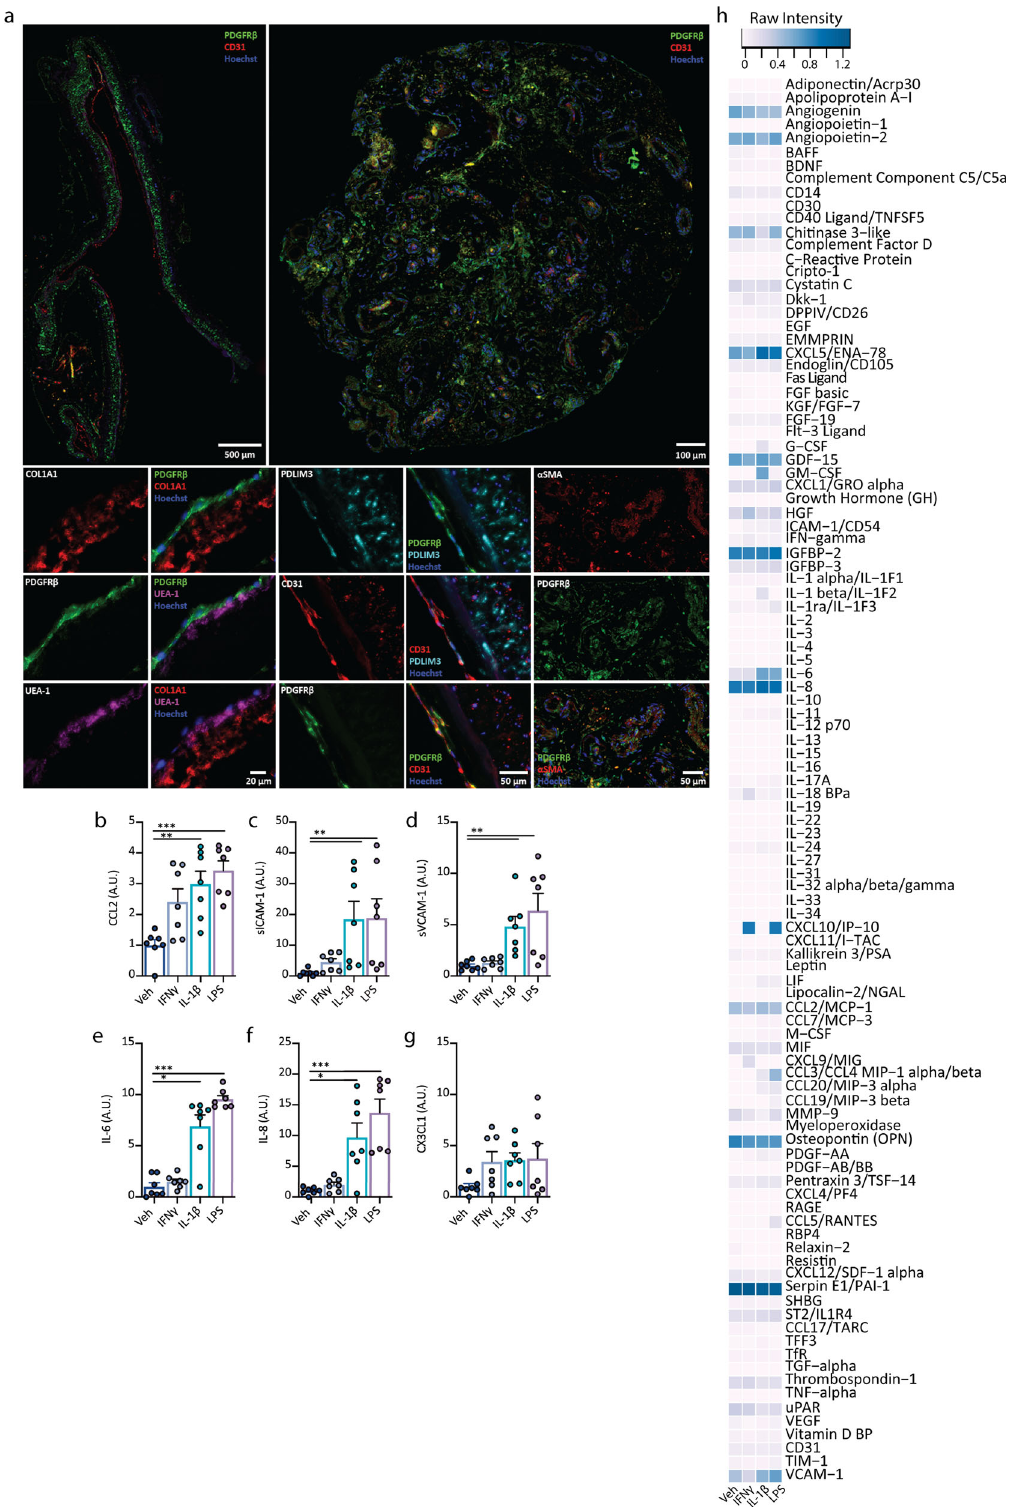
Fig. 5 Characterisation of leptomeningeal explant cell types and in fl ammatory signature. a Immunohistochemical staining of LME for vascular cells types including pericytes (PDGFR β ) endothelial cells (CD31), fi broblasts (PDLIM3), smooth muscle cells ( α SMA) and extracellular matrix protein deposition (COL1A1). b – g Secretions from meningeal explants following in fl ammatory stimulation with vehicle (white bars), IFN γ (blue bars), IL-1 β (cyan bars) or LPS (violet bars) were investigated using cytometric bead arrays ( n = 2 cases used: HC171, AZ129, 3 – 4 explants per case), values normalised to vehicle condition. One way ANOVA, Dunnett ’ s multiple comparisons test, mean ± SEM. *** p < 0.001, ** p < 0.01, * p < 0.05, raw values Figs. S7 and 8. h Proteome pro fi lers were used to detect secretions from human brain meningeal explants (pooled from fi ve explants per condition, one case: H250) after 24 h of in fl ammatory stimulation with vehicle, IFN γ , IL-1 β or LPS (10 ng mL − 1 ), raw intensities were normalised to reference spots.